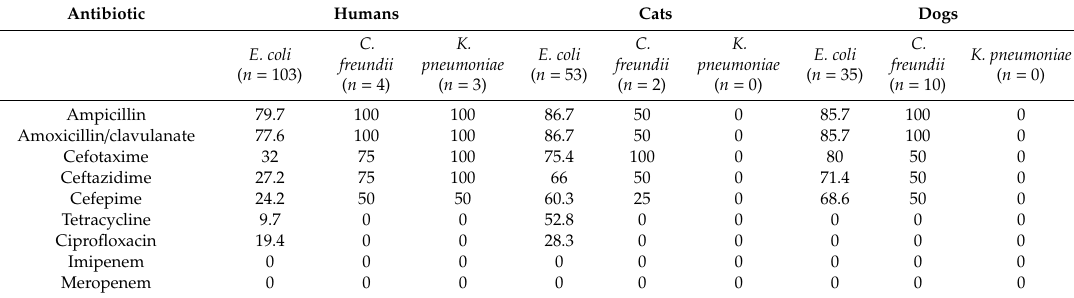
Table 3. Percentages of antimicrobial resistance in Enterobacteriaceae isolated from fecal samples of humans, cats, and